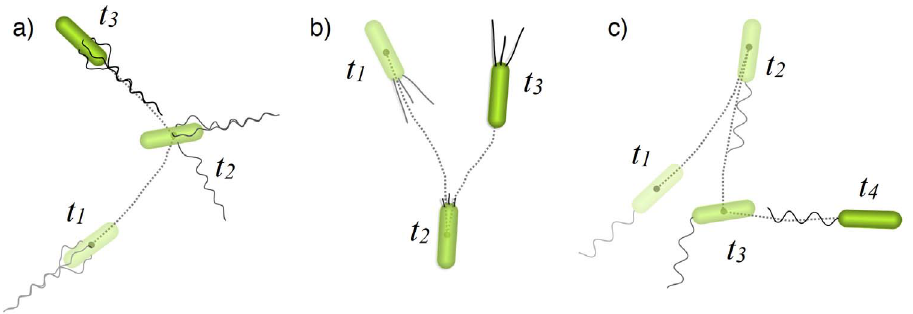
Figure 1. Sketch of the predominant motility patterns. a) Run-and-tumble, b) Run-reverse, and c) Run-reverse-flick. During a ‘‘run’’ event, a cell moves with high persistence. Runs are interrupted by reorientation events like tumbling or reversal. The time steps t 1 v t 2 v t 3 v t 4 indicate the sequence of these events. An average turning angle after tumbling in E. coli bacteria is * 70 0 (a), whereas it is an almost perfect reversal of 180 0 for many marine bacteria, or cells with twitching motility due to cell appendages, called pili (b). V. alginolyticus (c) alternates reversals (at t 2 ) with